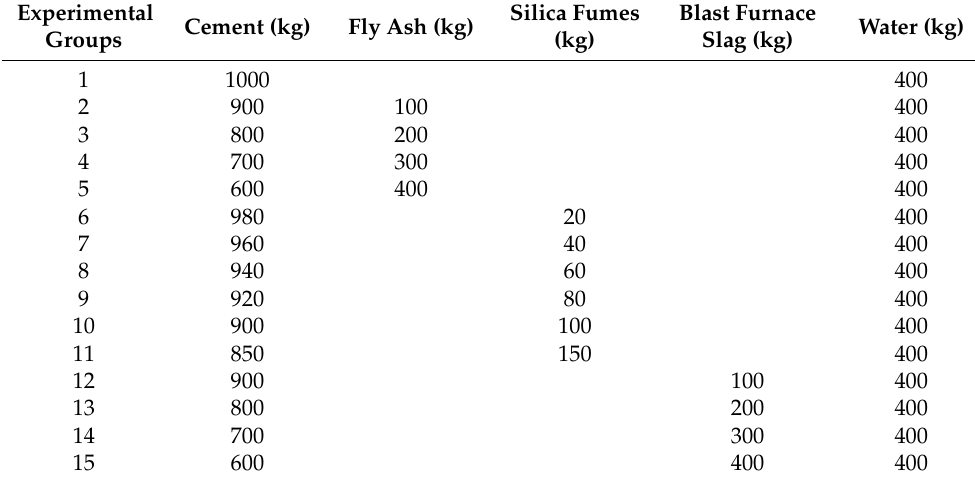
Table 2. Mix proportion of the pastes.